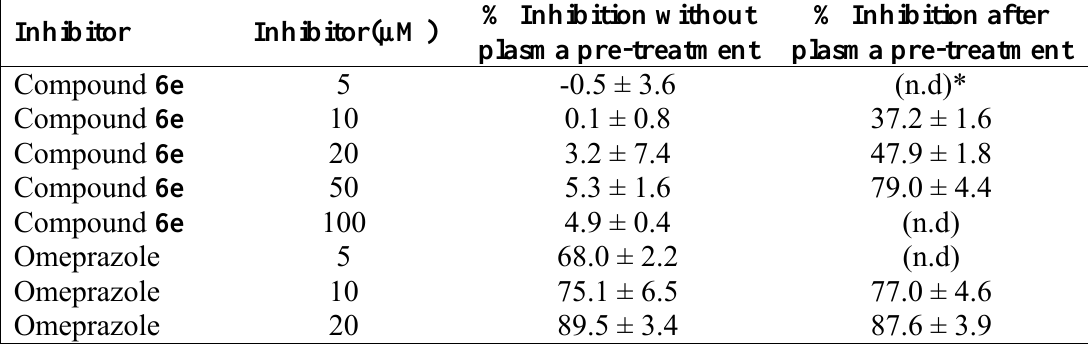
Table 1. Inhibition of H + ,K + -ATPase by compound 6e without plasma or plasma fraction pre-treatment or after pre-treatment of the